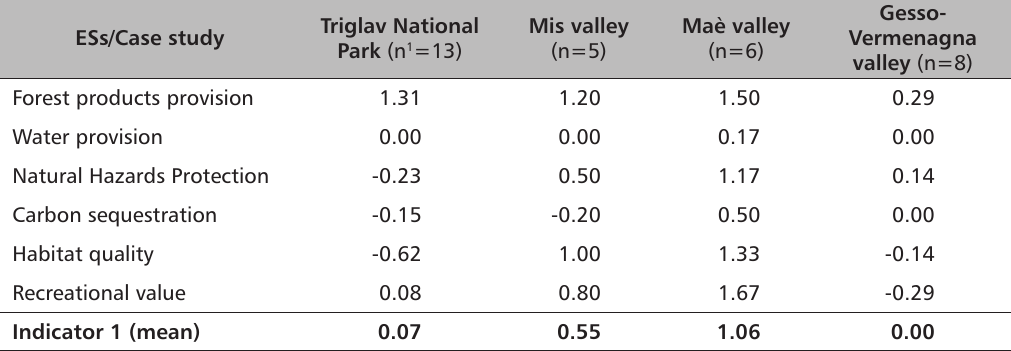
) by case study 1